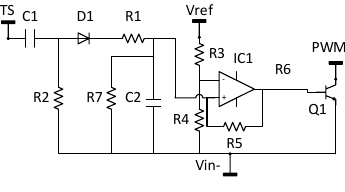
Fig. 2. Short circuit protection circuit diagram.